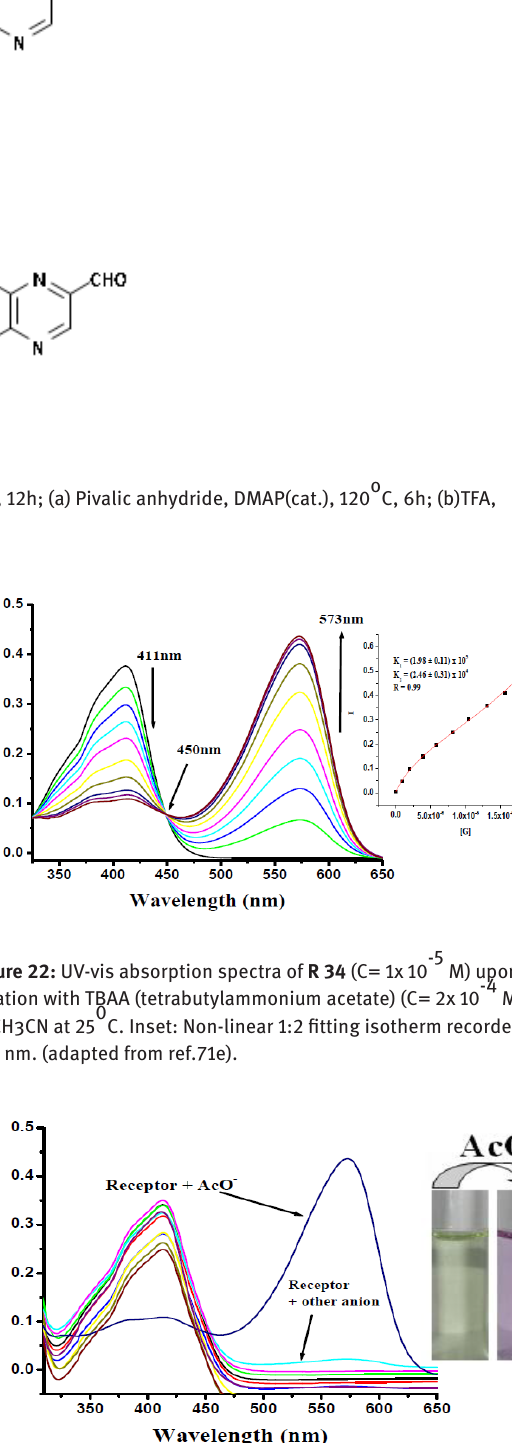
Figure 23: UV-vis absorption spectra of R 34 upon titration with all the testing anions in CH 3 CN with the naked eye color change of R 34 in presence of acetate .